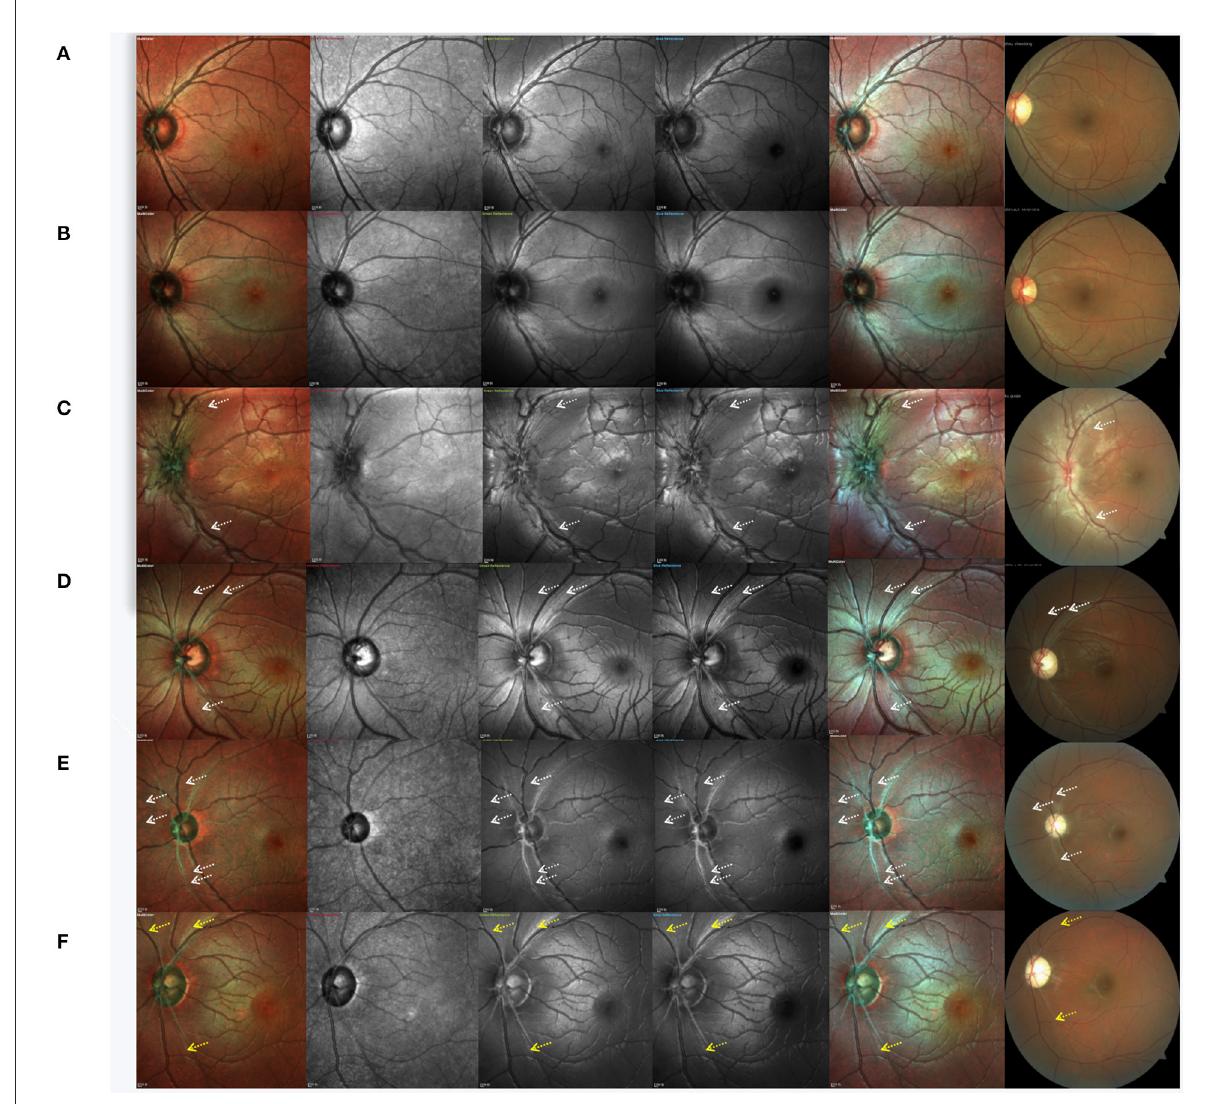
FIGURE3 Cases of a normal subject, asymptomatic carrier and Leber hereditary optic neuropathy patients at different clinical stages. (A) normal subject, (B) asymptomatic mutation carrier, (C) LHON at the subacute stage, (D) LHON at the dynamic stage, and (E,F) LHON at the chronic stage. White arrows indicate the positions of retinal nerve fiber layer defects, and yellow arrows indicate remnants of the retinal nerve fiber